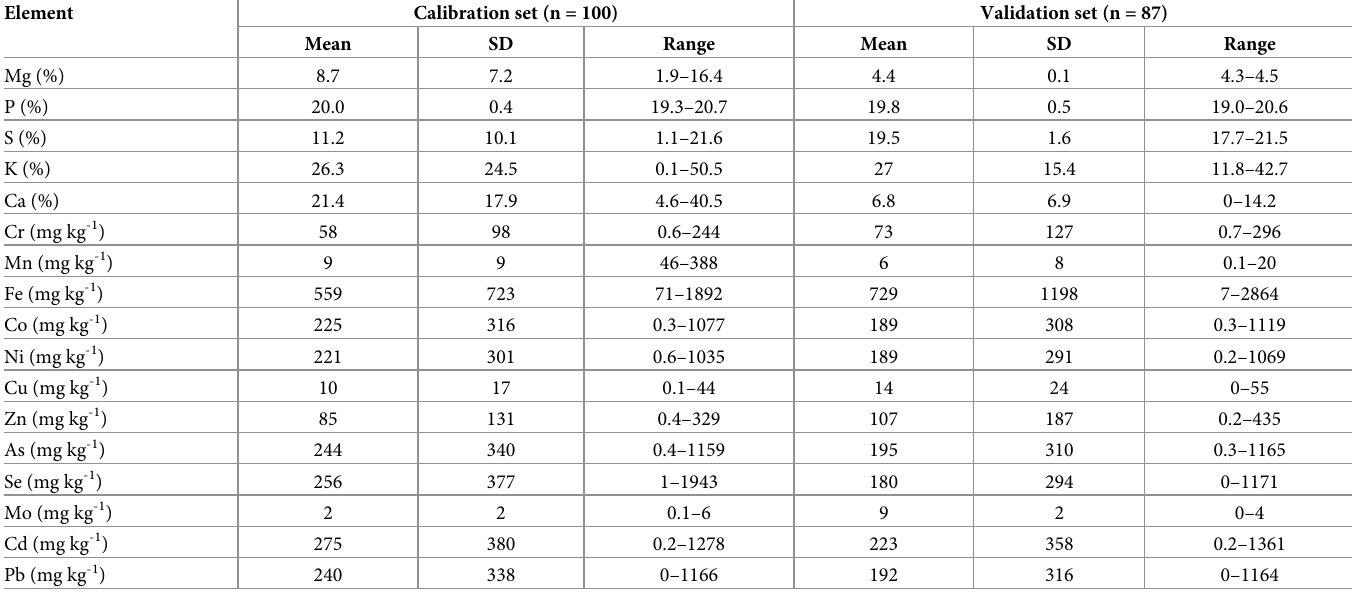
Table 4. Descriptive statistics of elements of interest in the Fertiliser Trace model.